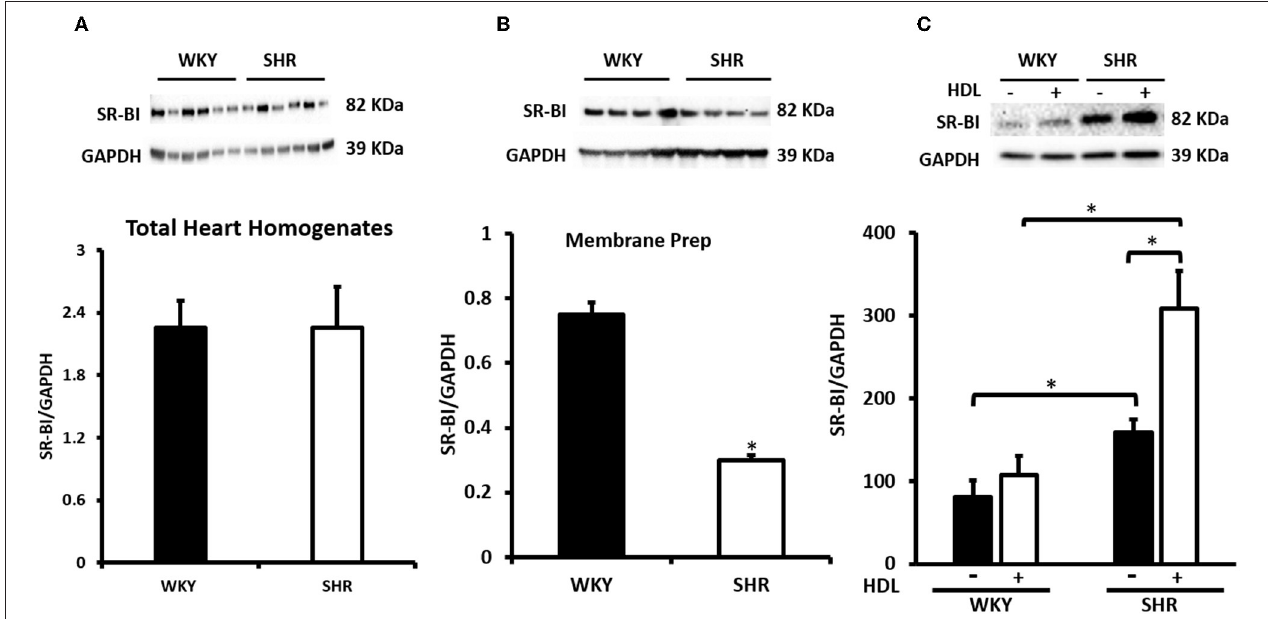
FIGURE 6 | Cardiac SR-BI Expression in WKY and SHR. Total heart homogenates (A) and membrane preparations (B) from WKY and SHR and total heart homogenates from WKY and SHR implanted with vehicle or HDL containing osmotic pumps (C) were subjected to immunoblotting against SR-BI and GAPDH as a loading control. Data are expressed as means ± SEM, * P < 0.05, n = 5–6 rats per